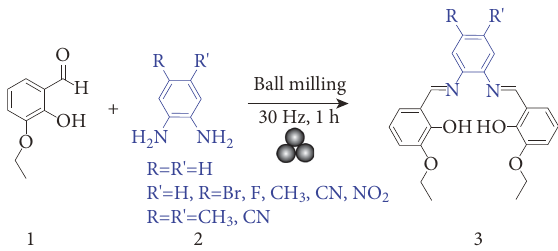
Scheme 1: Solvent-free mechanochemical synthesis of Salophen